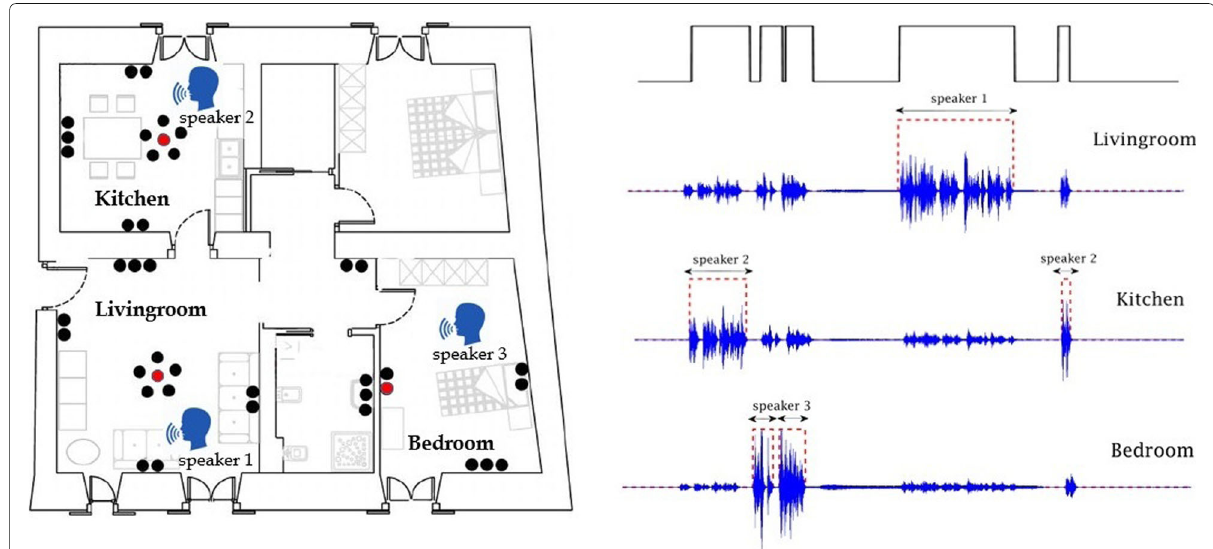
Fig. 1 An example of room-independent vs. room-localized SAD in multi-room domestic environments equipped with multiple microphones. Here, three speakers are active in three rooms. Left: floor plan of the smart home used in the DIRHA project [10] (see also Section 7.1 and Fig. 6), with dots indicating microphone locations on the apartment walls and ceiling. Right: 1-min-long waveforms, captured by the red-colored microphones (one per room with an active speaker), shown together with the corresponding ground truth of room-localized SAD. The